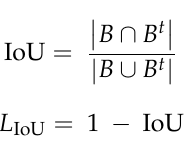
Figure 7. Aircraft target aspect ratio distribution.